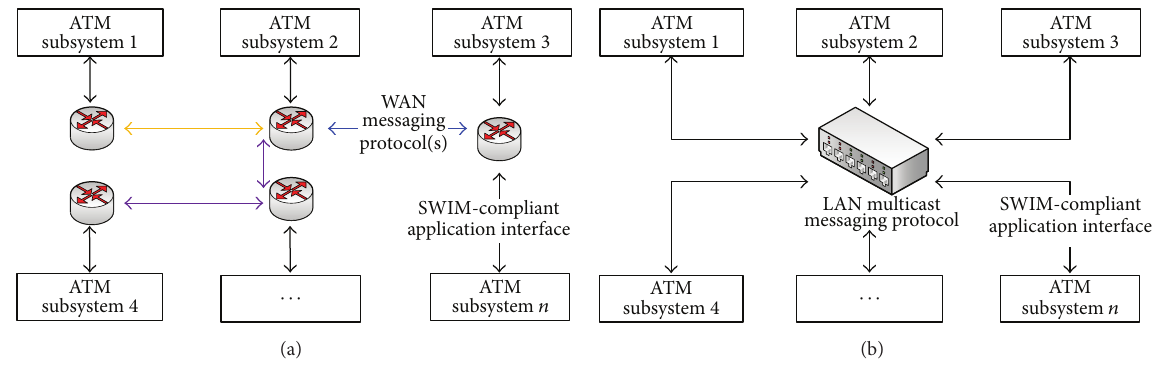
Figure 2: (a) The SESAR SWIM infrastructure is implemented by a Wide Area Network (WAN) of message brokers implementing several communication profiles. (b) Our method replaces the SWIM infrastructure with a local area multicast network (LAN) and the X23 communication profile.